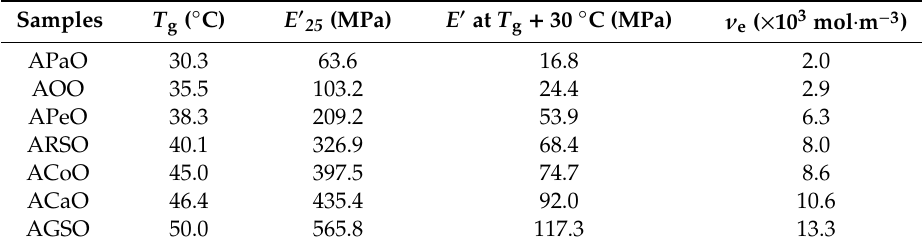
Table 2. Dynamic mechanical properties and cross-linking density of the UV-cured films.